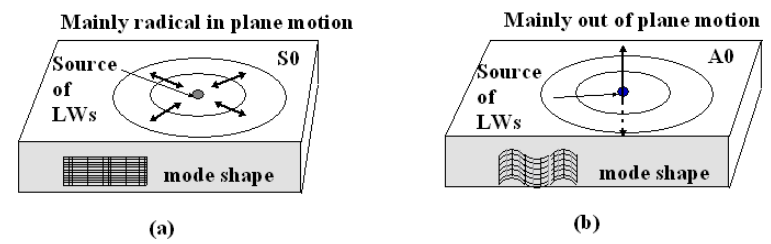
Figure 1. Schematics of mode shape and resulting motions of ( a ) S0 and ( b ) A0 modes at relatively low frequency.